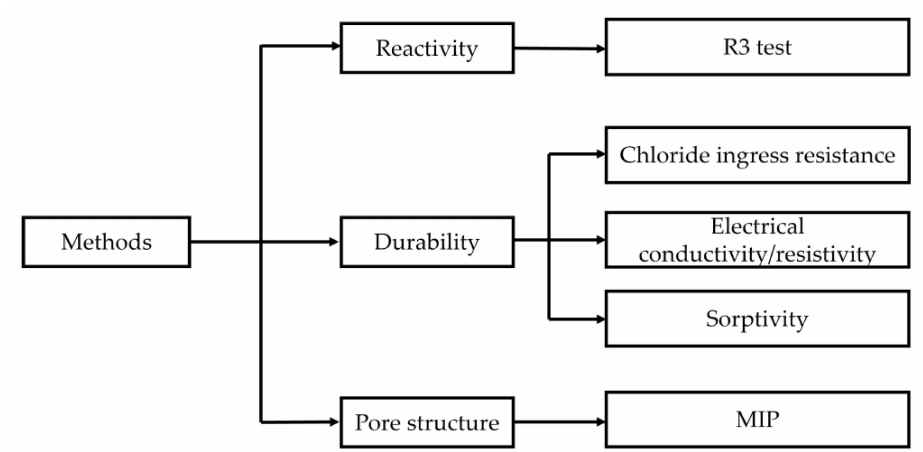
Figure 4. Layout of the experimental